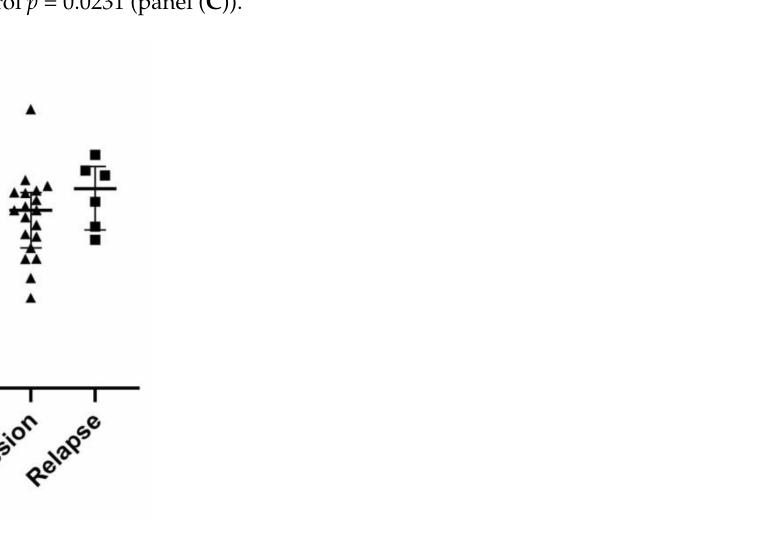
Figure 4. Memory T-cell percentage among total T cells. Memory cells were gated as CD62L+/CD44+. Data presented as median and